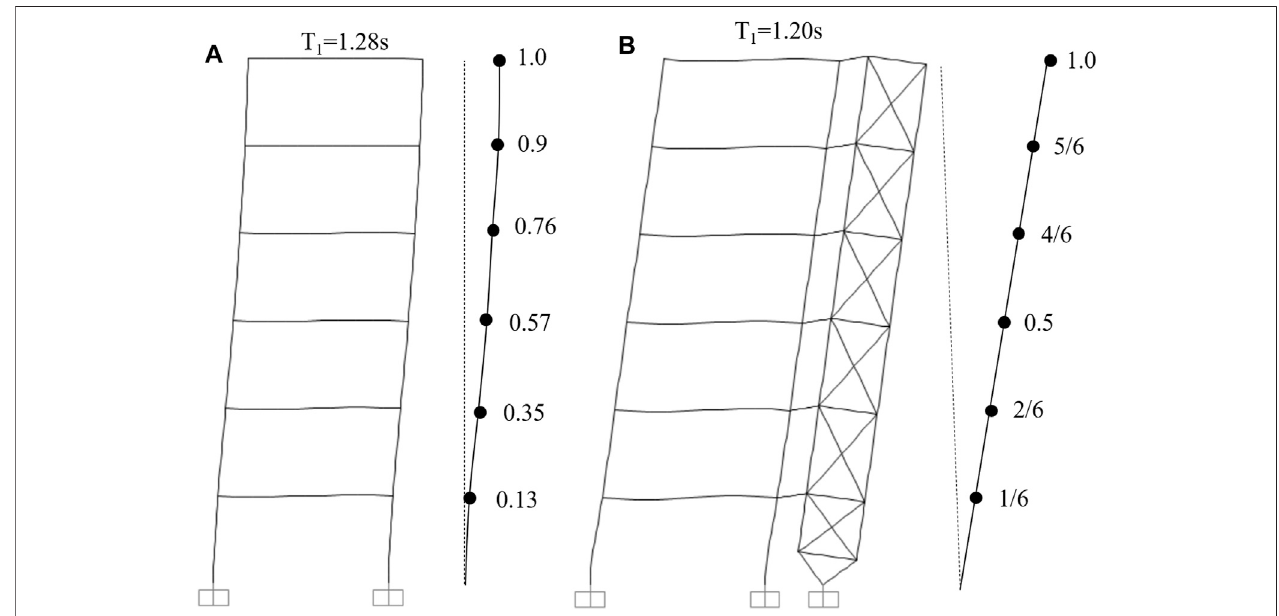
FIGURE 6 | (A) First-mode shape of the uniform bare frame; (B) First mode shape of the uniform frame connected with the strongback.